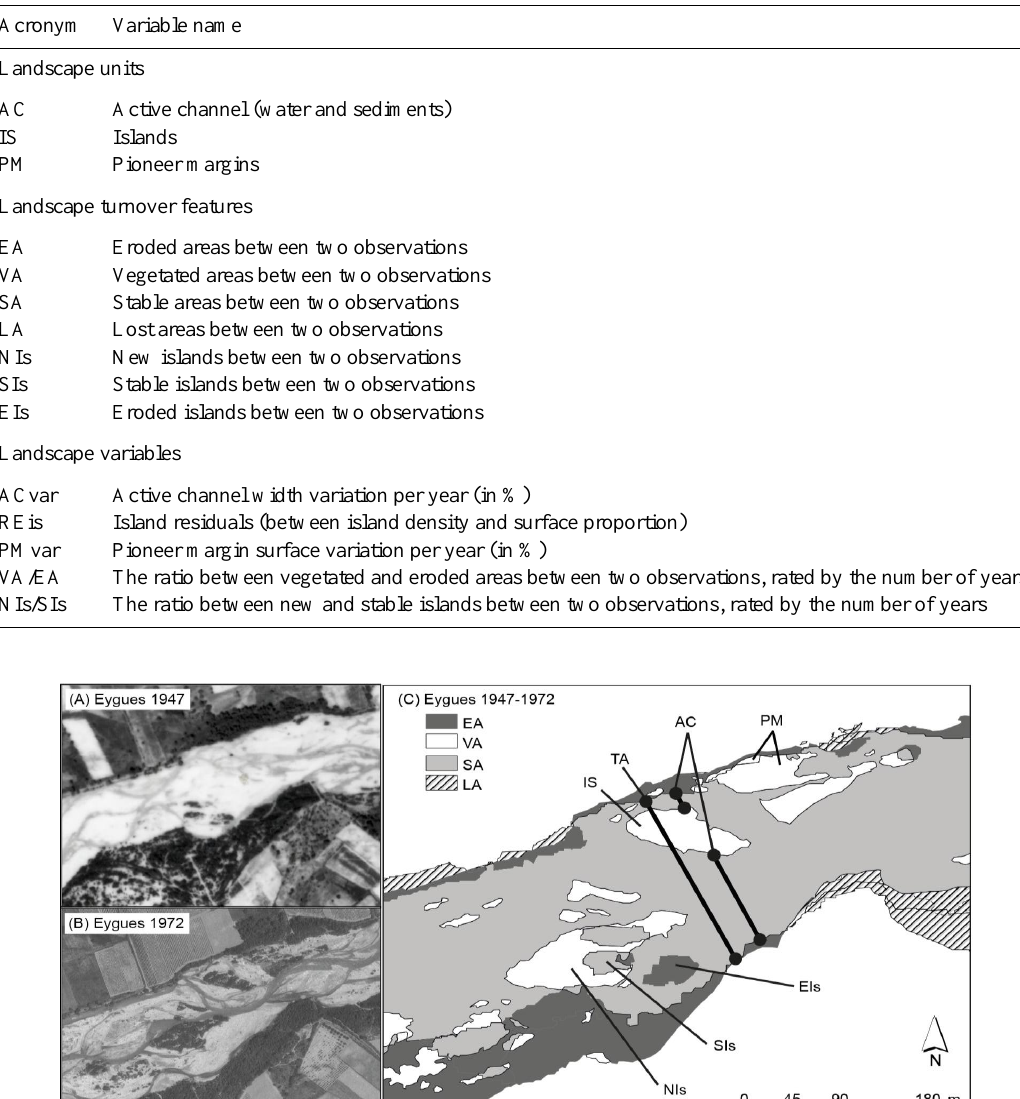
Table 2. List of acronyms employed in the text.